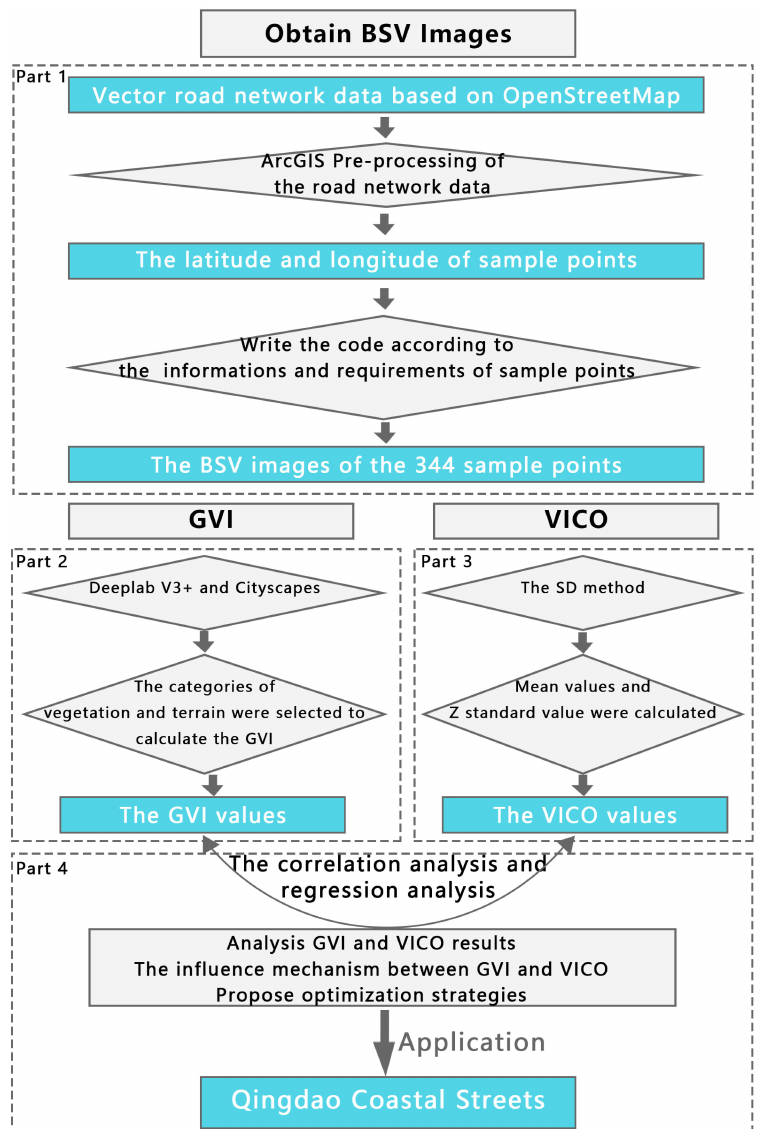
Figure 2. Methodology and application step diagram.